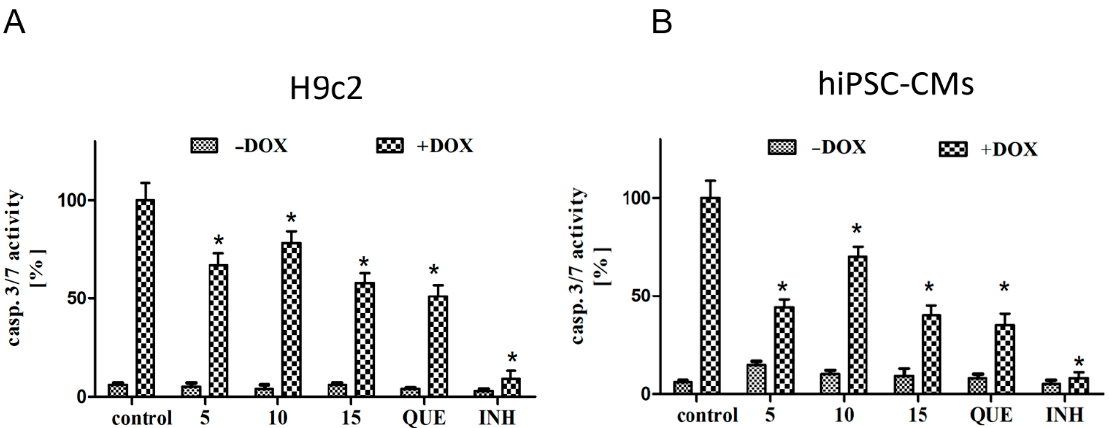
Figure 2. The protective effects of compounds 5 , 10 , and 15 against doxorubicin-induced apoptosis. ( A ) represents the results for H9c2 and ( B ) for hiPSC-CMs. Cells were seeded into 96-well plates; after 24 h, cells were pre-incubated in the presence of the compounds ( 5 , 10 , 15 , and QUE ) for 24 h, and then DOX was added for the next 24 h. Luminescent detection of caspase-3 and -7 was performed according to the manufacturer’s specifications. Caspase-3/7 activation results are expressed as a percentage (mean value for condition × 100/control) ± SEM, n = 9. Statistical significance (*) was calculated relative to control ( p < 0.05) separately for DOX (–) and DOX (+) conditions. Cells were incubated with or without the wide-ranging caspase inhibitor (INH) Z-VAD-FMK at a concentration of 20 µM, in order to indicate the caspase-dependent mechanism of apoptosis.